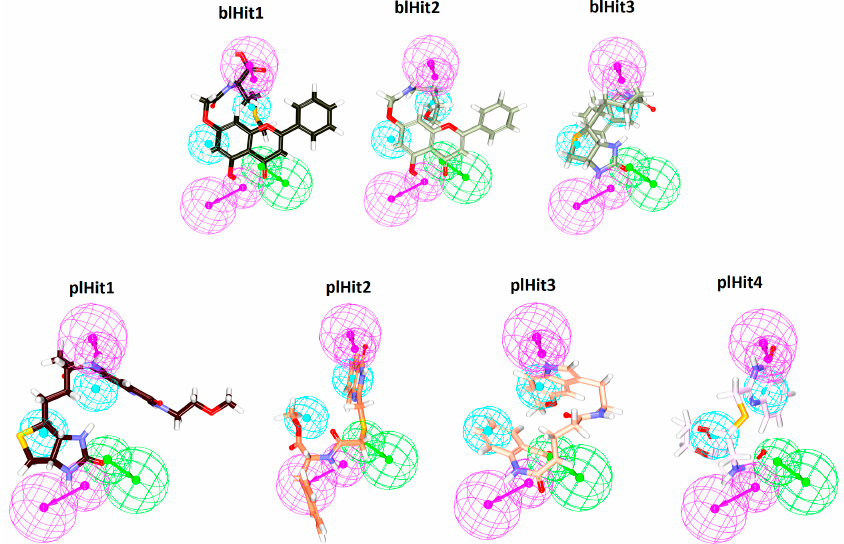
Figure 7. Alignment of the identified compounds with the pharmacophore. All the compounds represent the pharmacophore features.